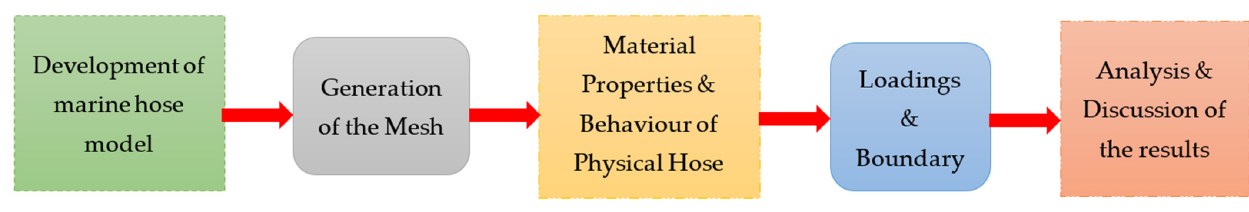
Figure 3. Methodology for the numerical model of the marine bonded composite hose model .